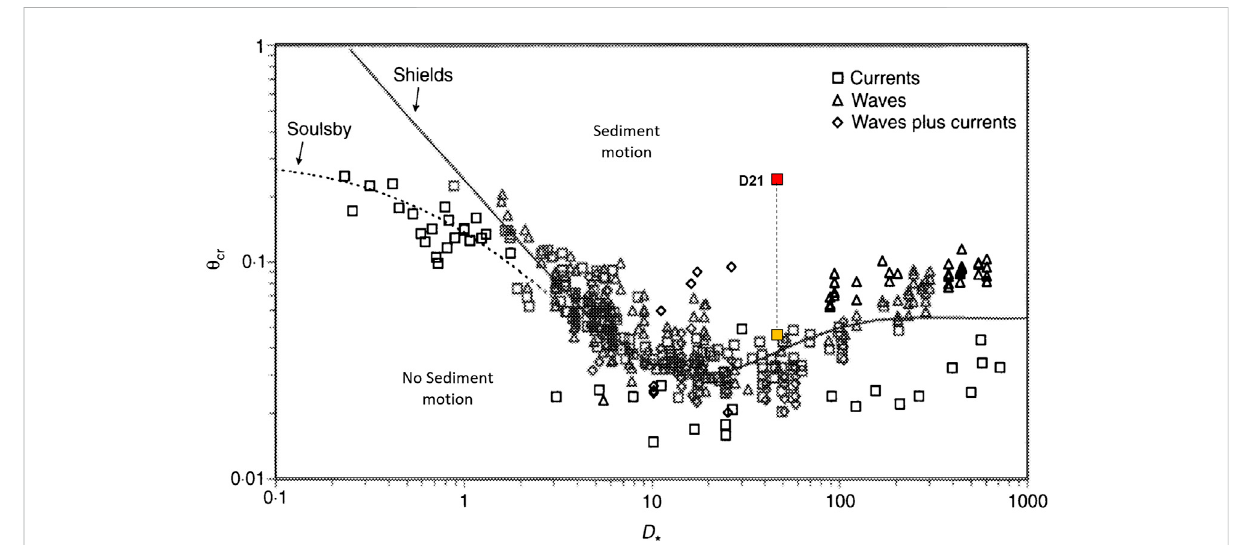
FIGURE 10 Threshold ofmotionofsedimentsbeneathcurrents(modi fi edfromSoulsby (1997), with θ cr beingthethresholdShieldsparameter andD * being thedimensionlessgrainsize)showingthatthegravelformingthebedformsinthestudyregionarecontinuouslyentrainedineachtidalcycle.Redand orange squares represent the maximum (95th percentile) and average bottom stress, respectively, in sampling site D-21 (see location of sample in Figure 3) Note: only sample D21 collected over the gravel dune fi eld was used for this analysis. This sample is composed of > 86% of gravel (see Table S1), and is over the threshold of motion of sediment, under maximum and average bottom stress conditions. Samples D1 and D23, collected adjacent to the gravel dunes fi eld (Figure 3), are cobbles with particle sizes ranging between 5 and 10cm; these particles are placed below the threshold of motion of sediment (Supplementary Figure